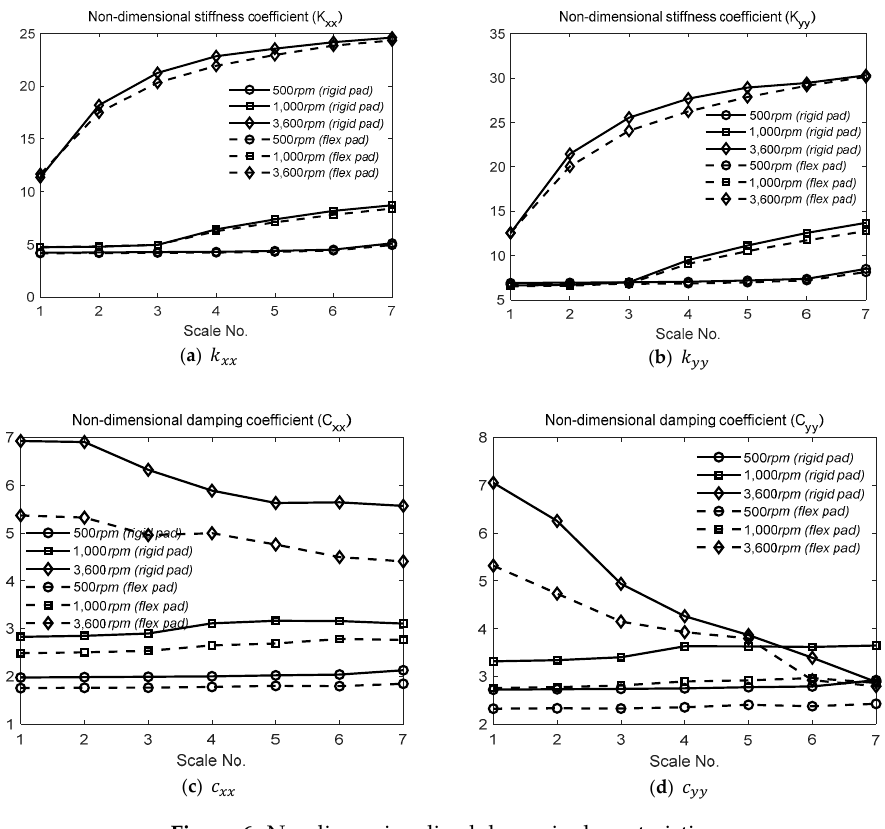
Figure 6. Nondimensionalized dynamic characteristics.